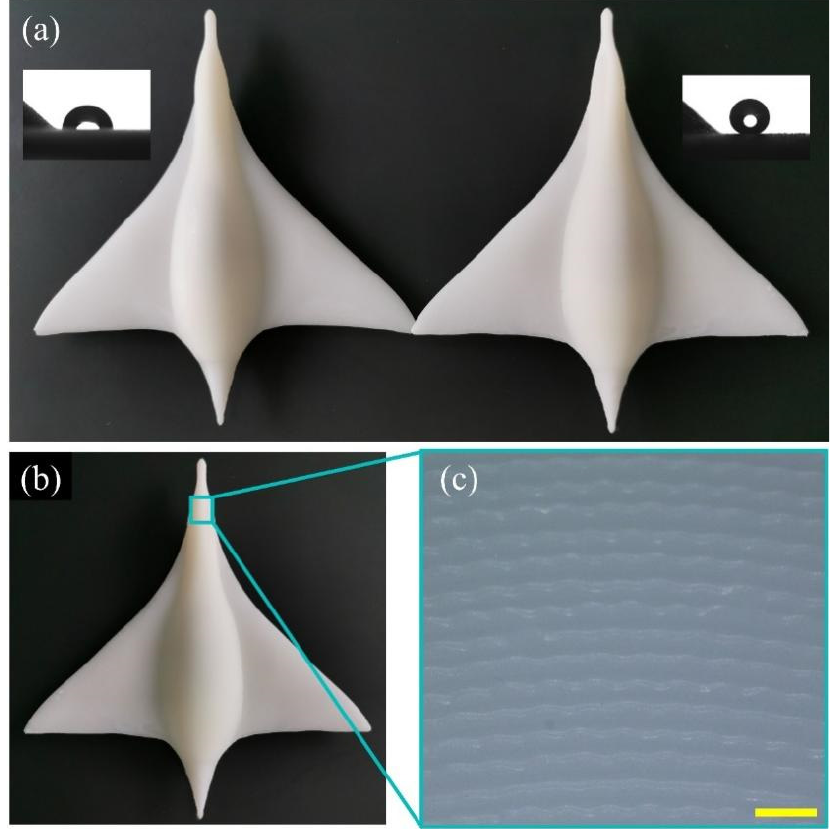
Figure 1. Surface texture and hydrophobicity characterizations of the models: ( a ) the 3D-printed models of aquatic UAV for comparative experiments; the insets indicate static wettability characterization of each model, indicating hydrophilic ( θ = 88 ◦ ) on the left, and superhydrophobic ( θ = 155 ◦ , θ S = 3 ◦ ) on the right; ( b , c ) show the anisotropic structure of the surface, which promotes the directional flow of liquids, observed by ultra-depth-of-field microscopy; the yellow scale bar is 400 µ m, and the magnification is 100.